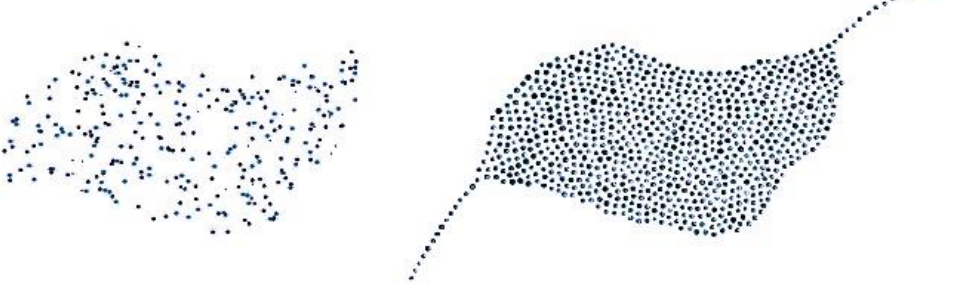
Figure 8. Jenny Johnstone. Water molecules producing shape and form, 2020.